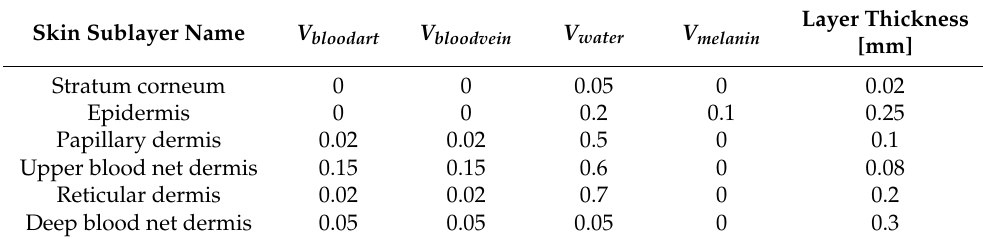
Table 1. Fractional volume and layer properties of the different skin